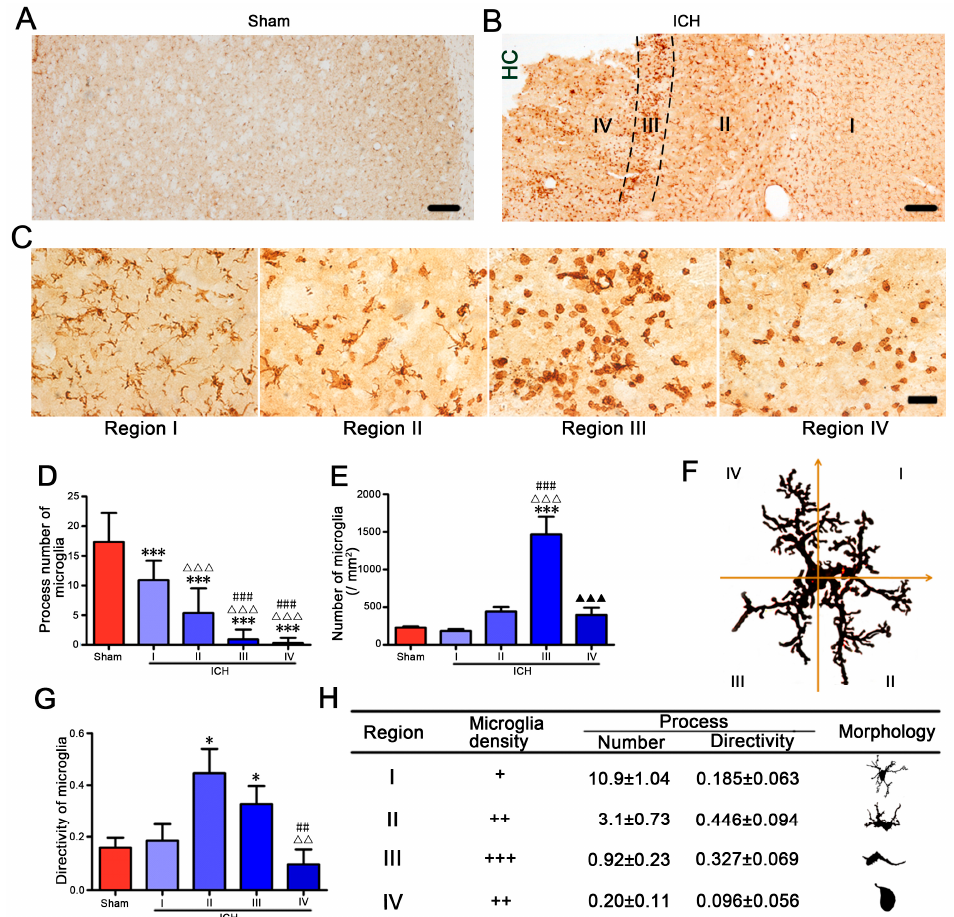
Figure 5. Microglia/macrophages showed high morphologic plasticity. Brain slices (20 μ m) were taken three days after operation from Sham rats ( A ) and ICH rats ( B , C ). By immunohistochemistry, Iba-1 marked microglia/macrophages in the left CPu were observed ( n = 3, Bar = 200 μ m). According to the distance to the hemorrhagic center (HC), we selected four areas ( B , C ) to analyze the morphologic features of activated microglia/macrophages, and the left CPu of sham rats was used as control (Sham, A , D , E ). The process numbers ( D ) and the densities ( E ) of microglia/macrophages were studied. To evaluate the process directivity of a microglia/macrophage, the cell body was set as the origin, and the y -axis was set pointing to the hemorrhagic center ( F ). The directivity was calculated as the process number in quadrants I and IV deducted the number in quadrants II and III, and the difference was divided by the total process number ( G ). The morphologic characteristics of activated microglia/macrophages after ICH was summarized in ( H ). Data were expressed as means ± SEM. * p < 0.05, *** p < 0.001, vs. Sham. ΔΔ p < 0.01, ΔΔΔ p < 0.001, vs. region I. ## p < 0.01, ### p < 0.001, vs. region II. ▲▲▲ p < 0.001, vs. region III.